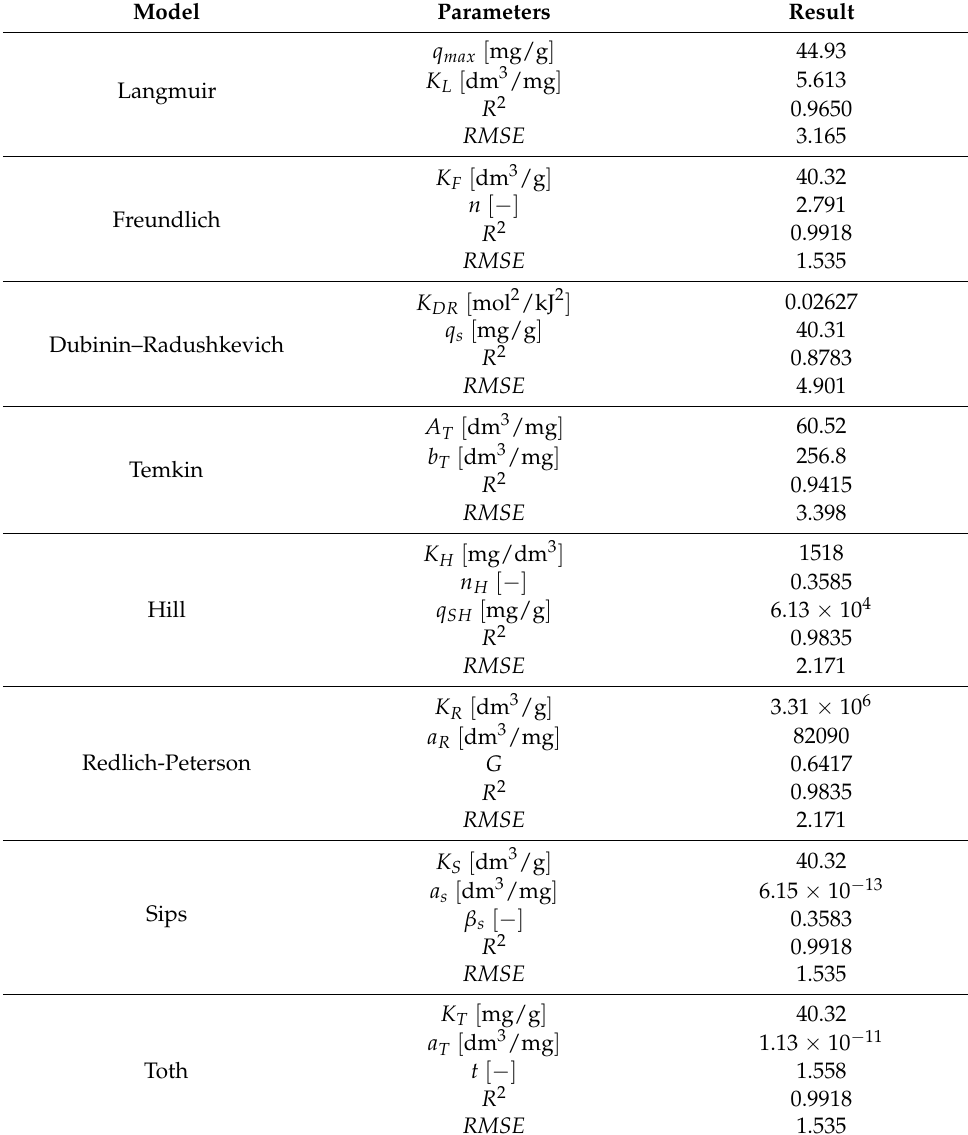
Table 4. Parameters of the determined nonlinear equilibrium